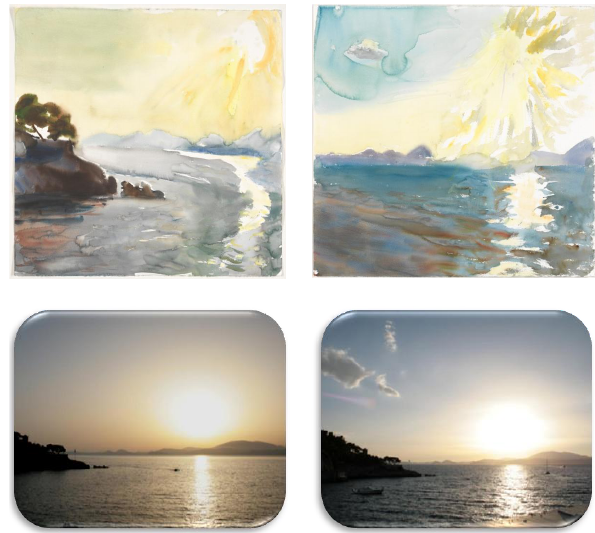
Fig. 10. Upper: digitally compressed paintings by P. Tetsis at the Hydra experiment under higher (left panel) and lower (right panel) AOD conditions. Bottom: digital camera photos of the landscape. Under each painting a digital photograph at the centre of the time interval it took to paint each painting is displayed for comparison (see